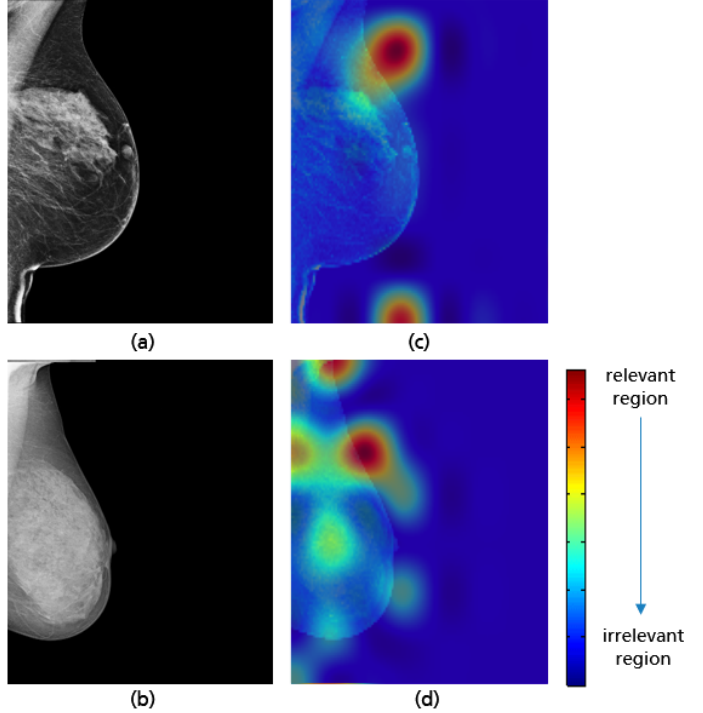
Figure 27. Examples of MLO views misclassified by the model with a not fully visualized retroglandular fat tissue ( a , b ), and their Grad-CAM ( c , d ) highlighting the relevant region for the model